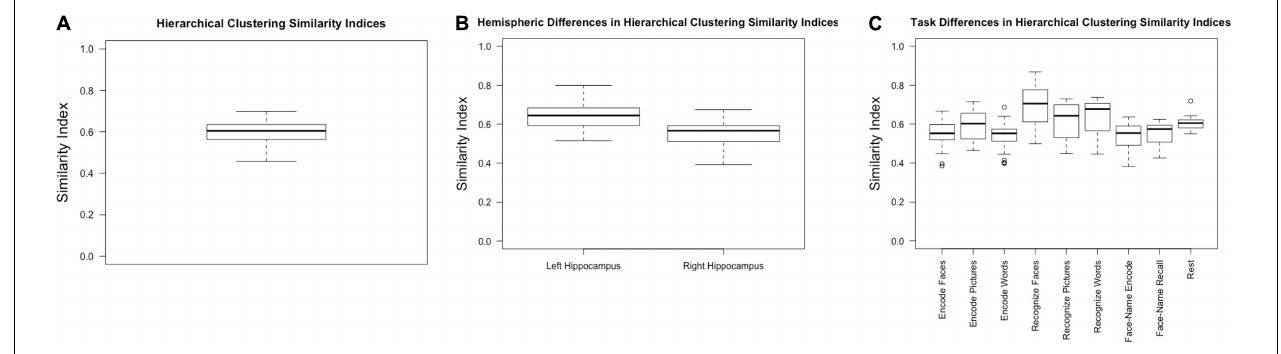
FIGURE 3 | Similarity indices for (A) hierarchical clustering across all participants, hemispheres, and tasks; (B) hierarchical clustering within the left and right hemispheres, collapsed across task; (C) hierarchical clustering within tasks, collapsed across hemisphere.